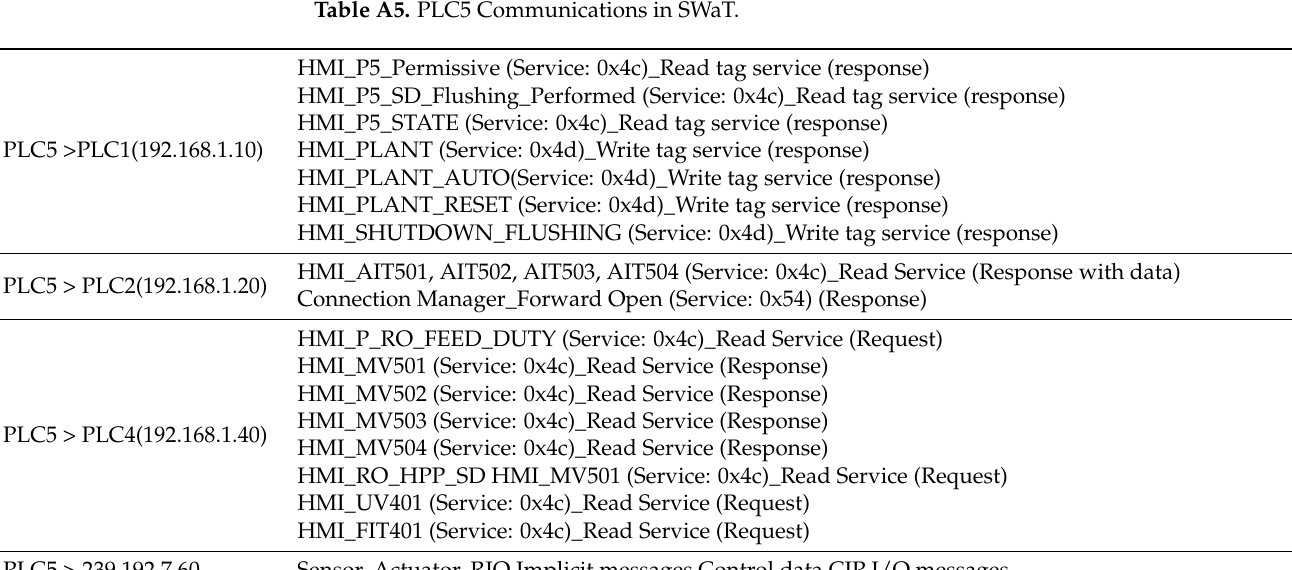
Table A5. PLC5 Communications in SWaT.